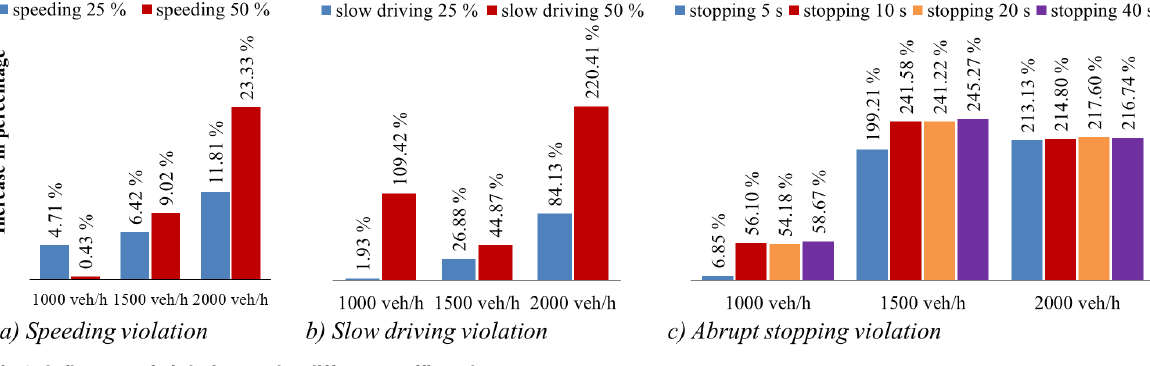
Fig 9. Influence of violation under different traffic